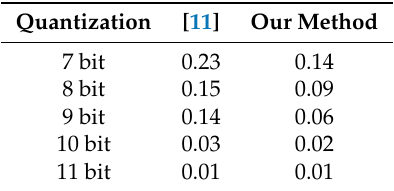
Table 9. Results of comparison with the robustness of Son et al.’s [11] method measured in terms of BER against